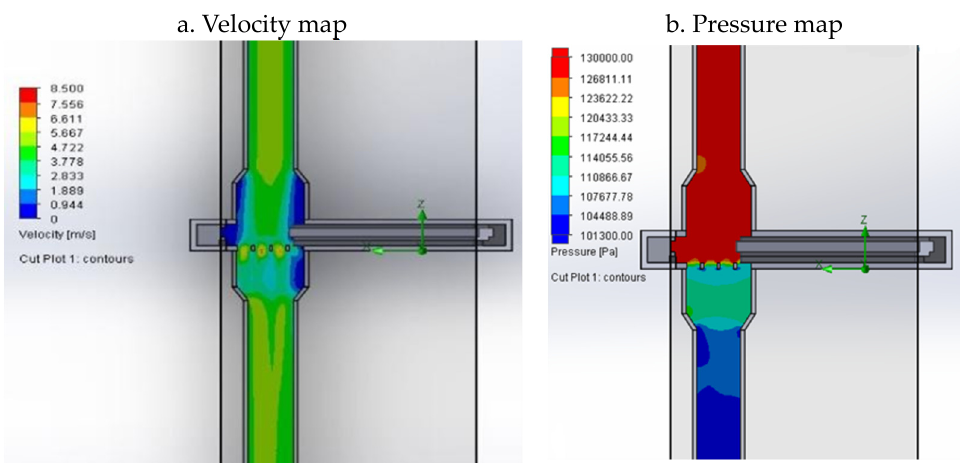
Figure 14. Second valve geometry with 90% opening.